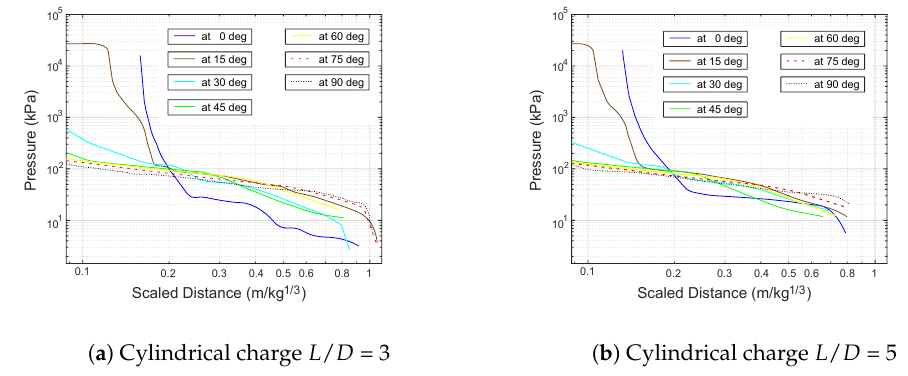
Figure 16. Comparison of incident pressure vs. scaled distance for cylindrical charges.